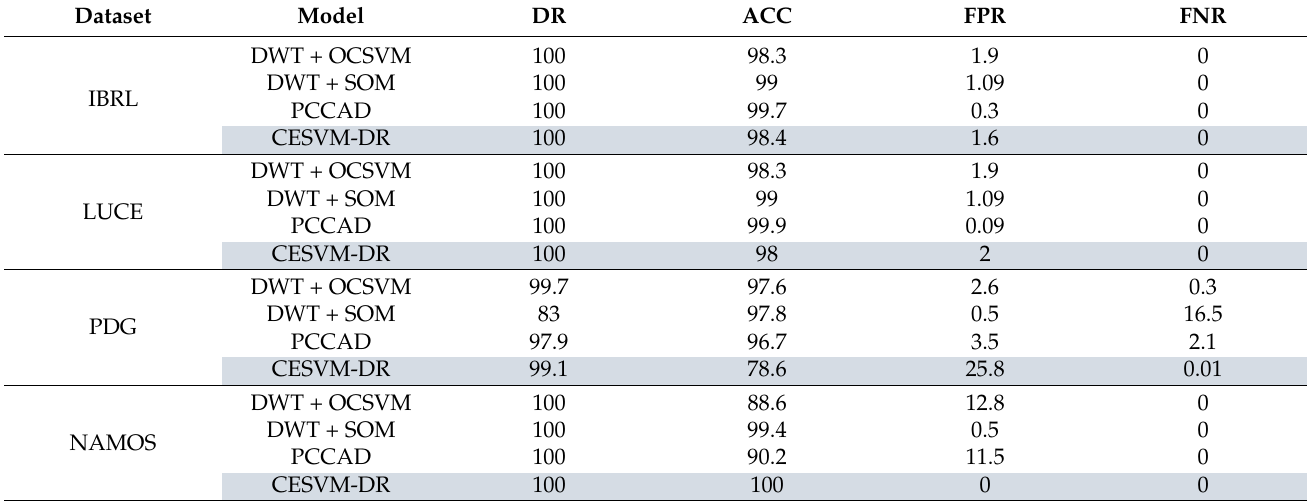
Table 3. The Comparison Proposed of Effectiveness Evaluation with Other Related Anomaly Detection Schemes Using Histogram-Based